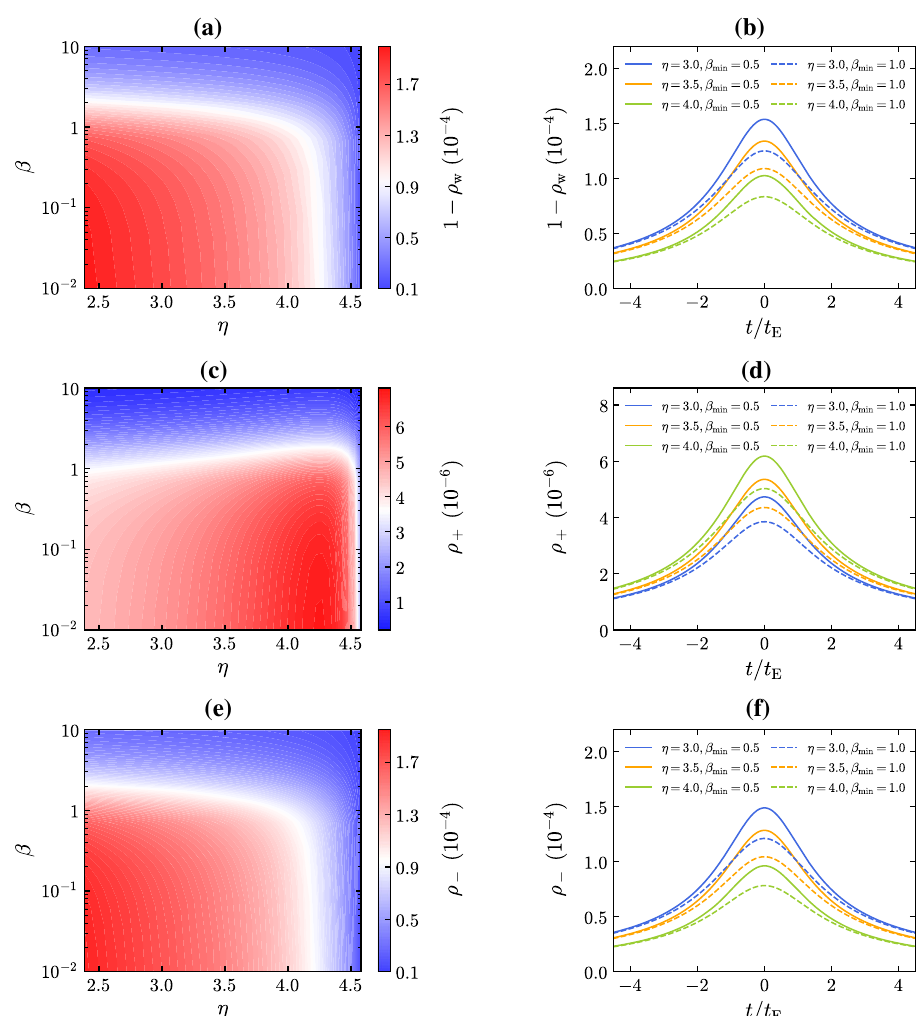
Fig. 7 Left column: the color-indexed fractional contributions ρ w and ρ ± on the domain of (η,β) . Right